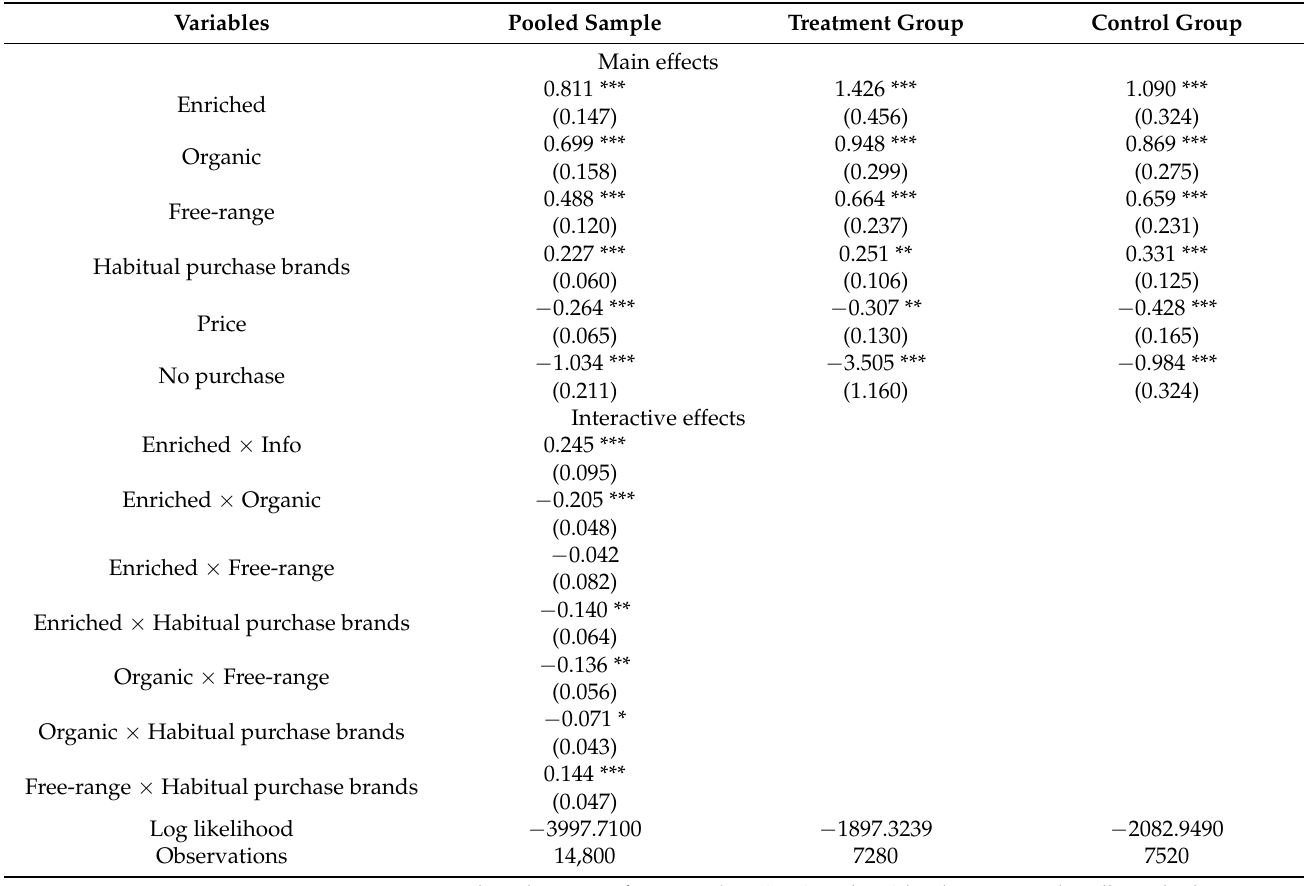
Table 4. Estimation results using a mixed logit